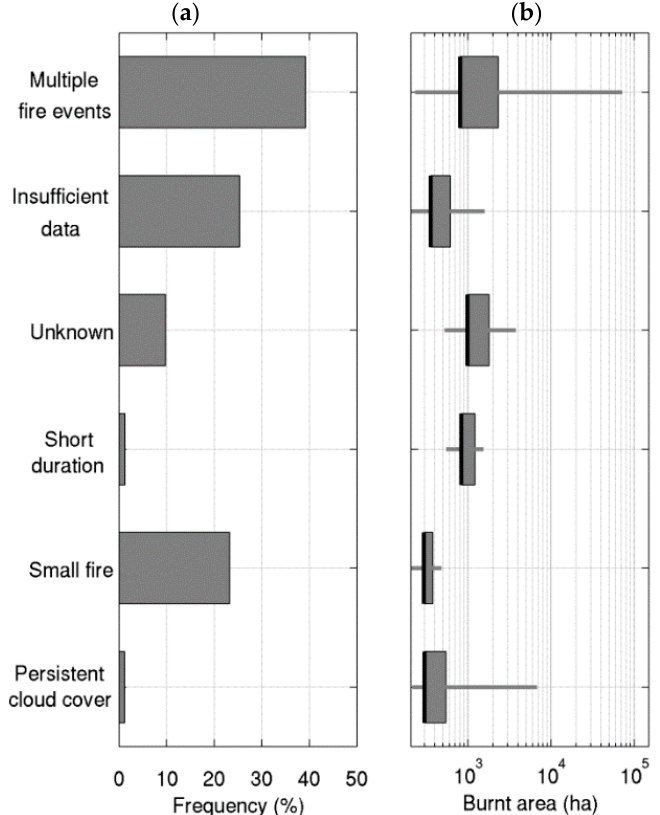
Figure 10. Main causes for the absence of satellite-derived fire dates and ignitions: ( a ) frequency and ( b ) associated fire size distribution ( N = 1135). For the fire size distribution, the boxes represent the interquartile range and the horizontal grey lines, the 5th and 95th percentiles. The median is represented in black.